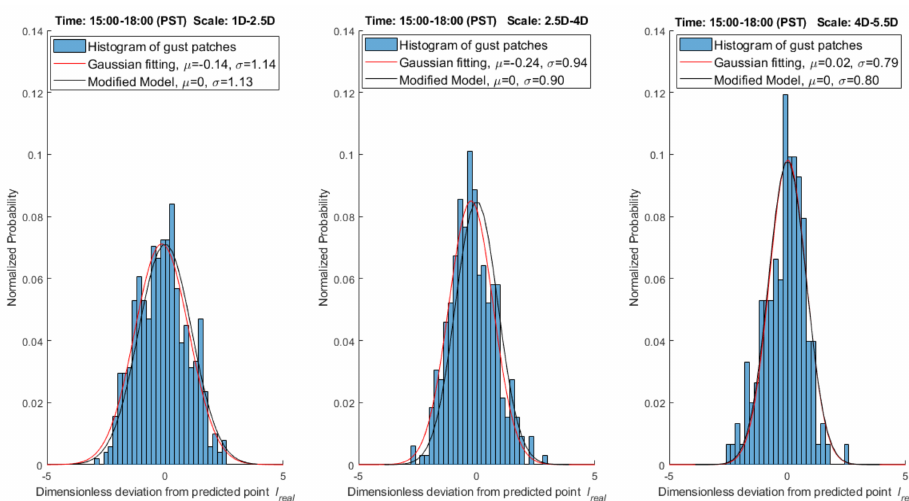
Figure 9. Normalized distribution probability of the modeled deviation (black lines) and real deviation (histogram) of the patches. The red lines are the fitting curves to the histograms. The same dataset was used as in Figure 6. The patches were separated into three groups according to their